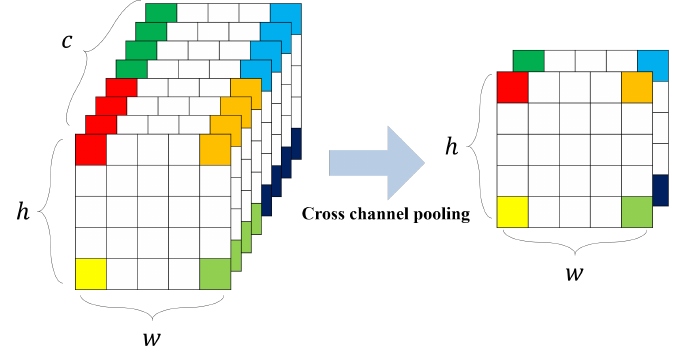
Figure 4. Illustration of the cross-channel pooling process. The pooling operation is done using the elements in the same location of each feature map. As a result, the width ( w ) and height ( h ) of the feature maps are preserved while reducing the dimensions of the channel ( c ).